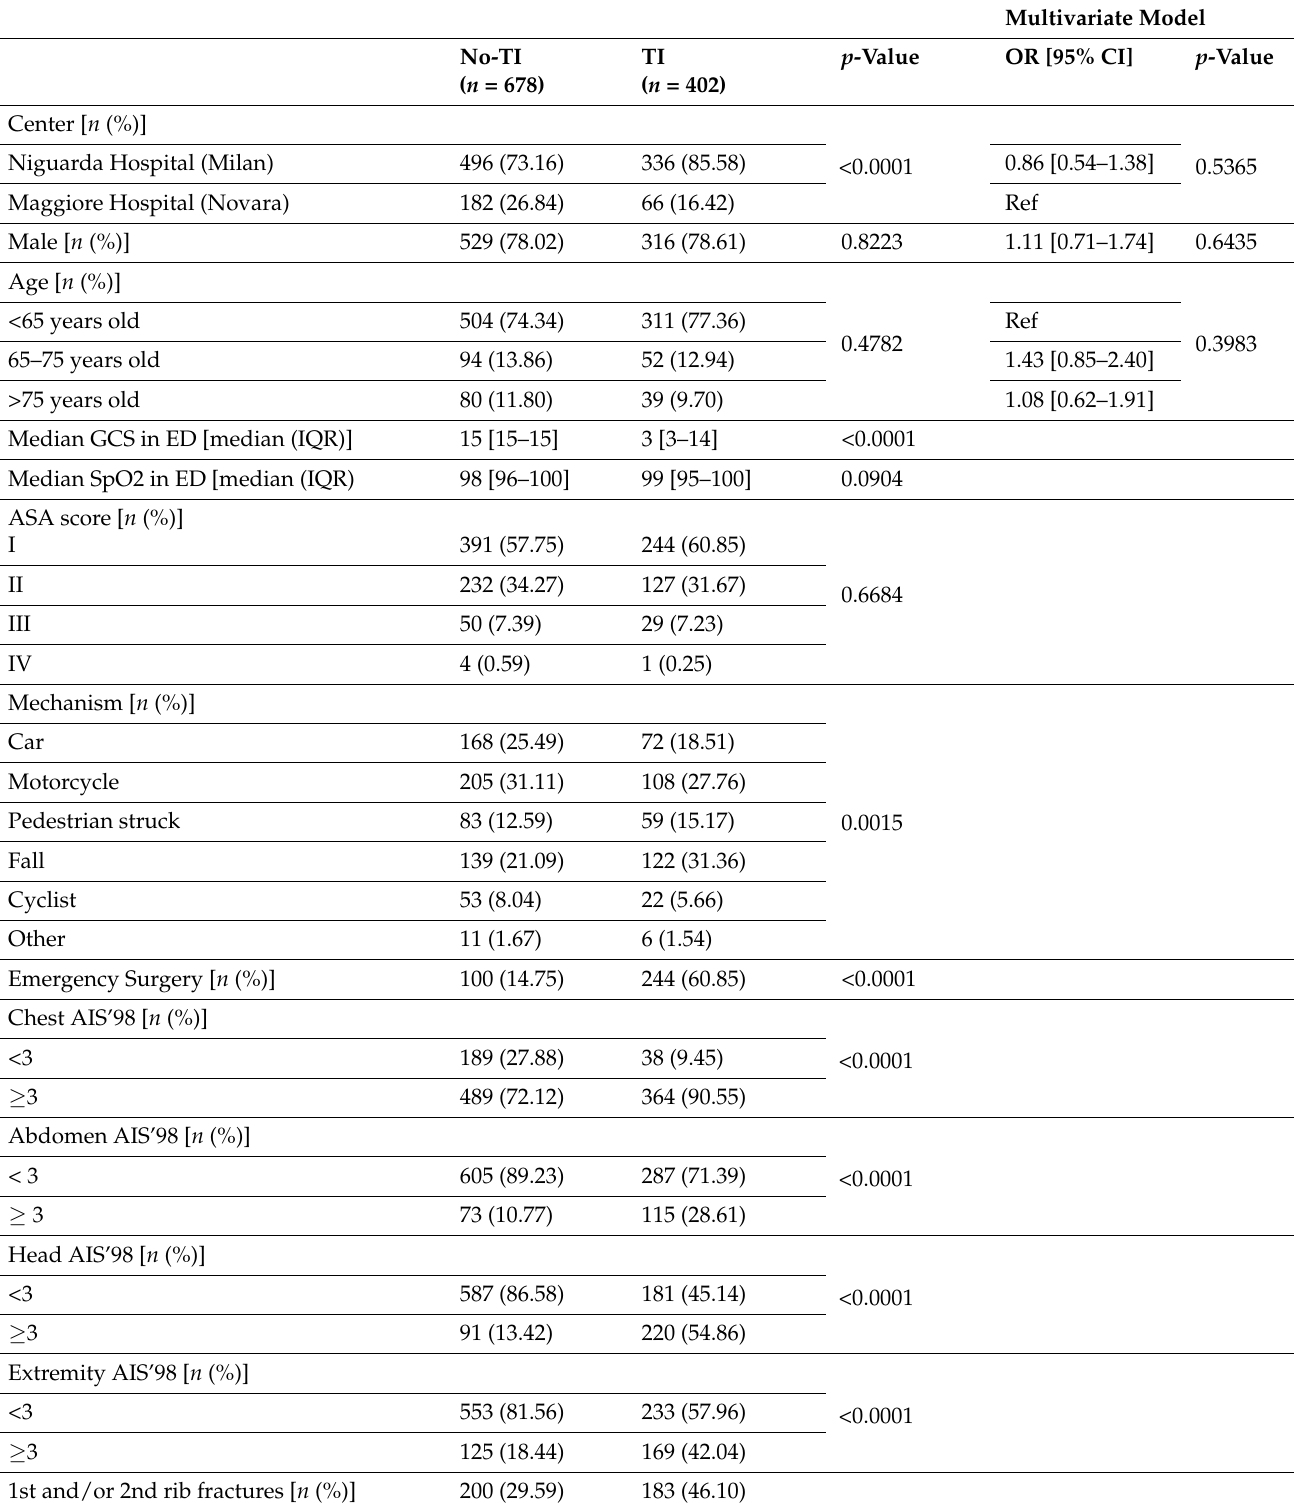
Table 2. Analysis between patients subjected or not subjected to Tracheal intubation